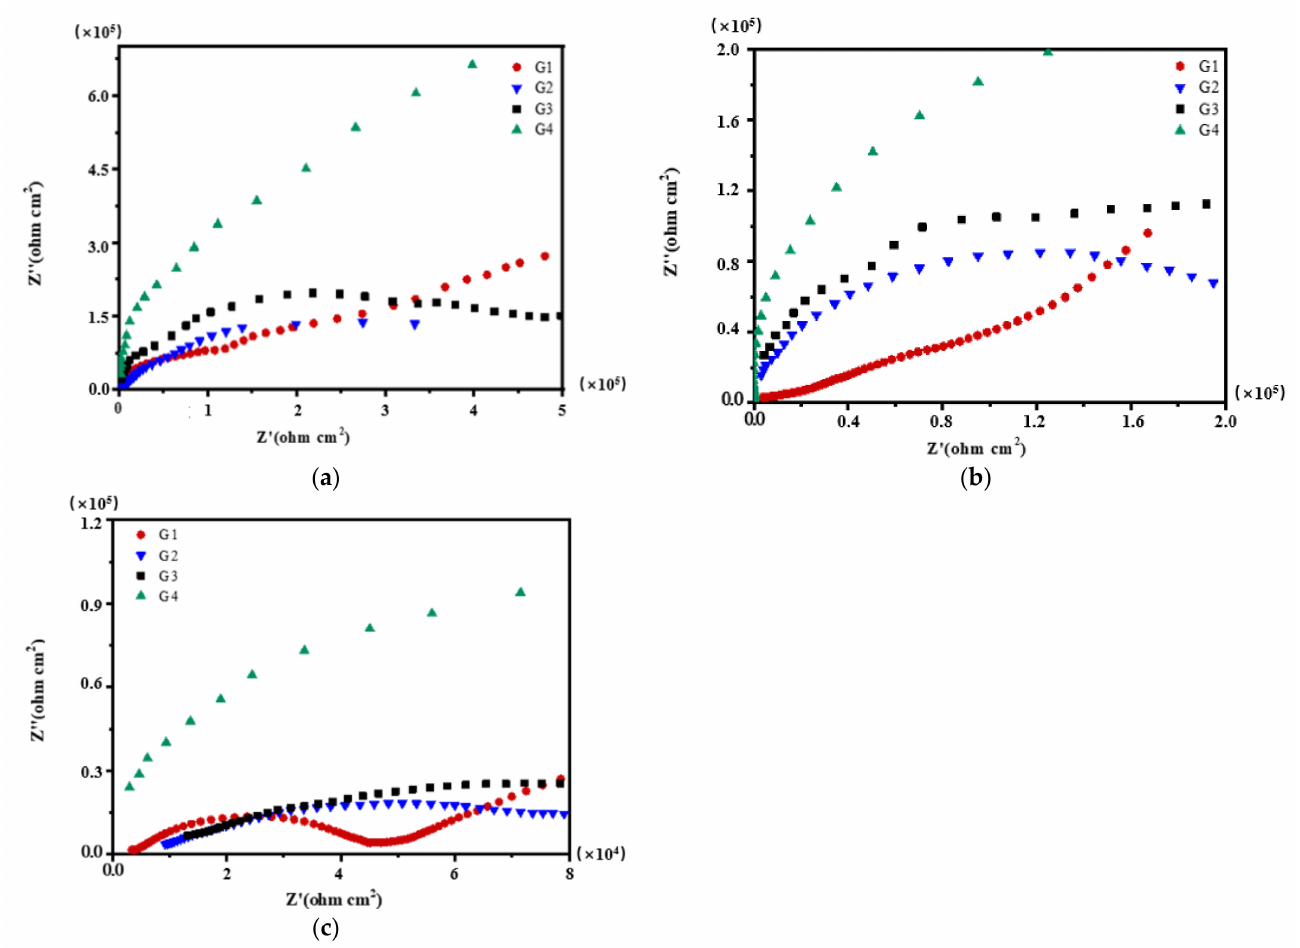
Figure 5. Each coating’s Nyquist pattern for immersion for 30 days: ( a ) 20% Seawater; ( b ) 40% Seawater; ( c ) 60%